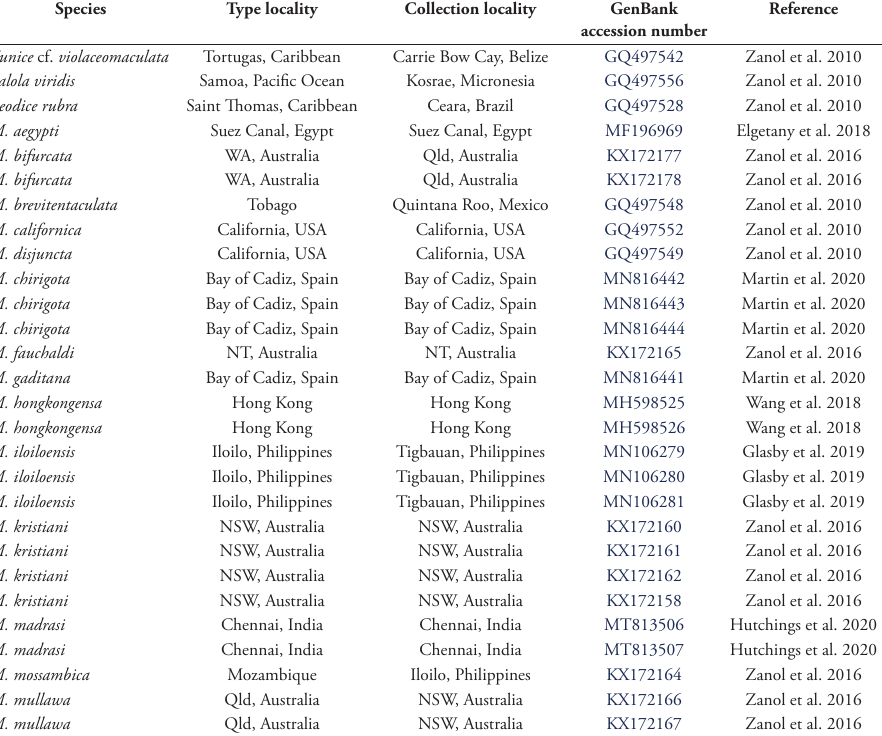
Table 1. Terminal taxa used in the molecular part of the study (COI gene), with type localities, collection localities, GenBank accession numbers, and